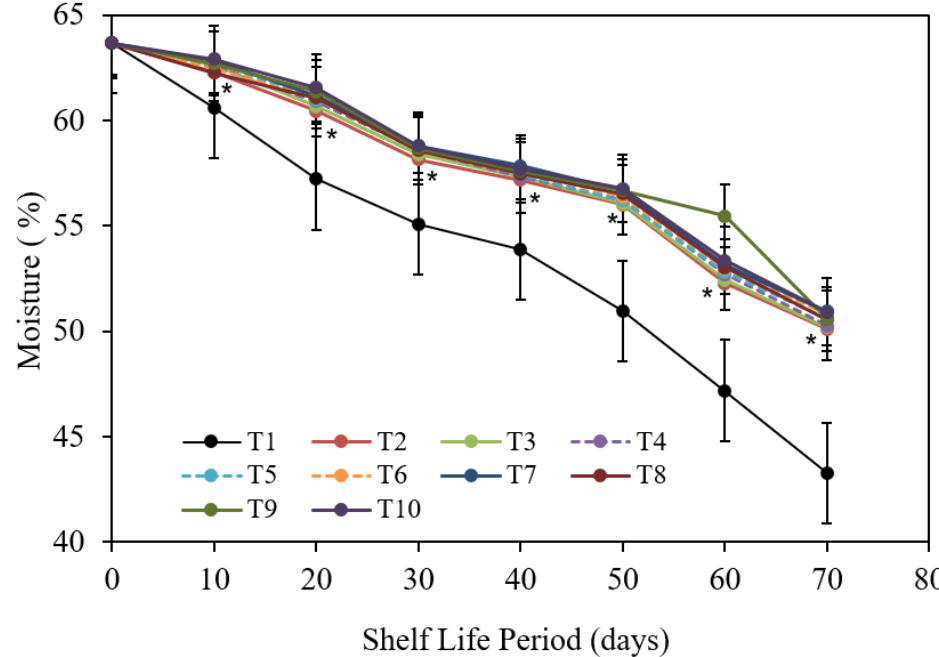
Figure 8. The impact of pre-harvest chitosan, chitosan nanoparticle, and CaCl 2 foliar spray treatments on moisture of Barhi date fruits under cold storing for 70 d. Note that * sign denotes the significant differences between the control and edible coatings treatments, and T1, T2, T3, T4, T5, T6, T7, T8, T9, and T10 are water (control), 1 g/L chitosan, 2 g/L chitosan, 3 g/L chitosan, 1 g/L chitosan nanoparticles, 2 g/L chitosan nanoparticles, 3 g/L chitosan nanoparticles treatments, respectively.